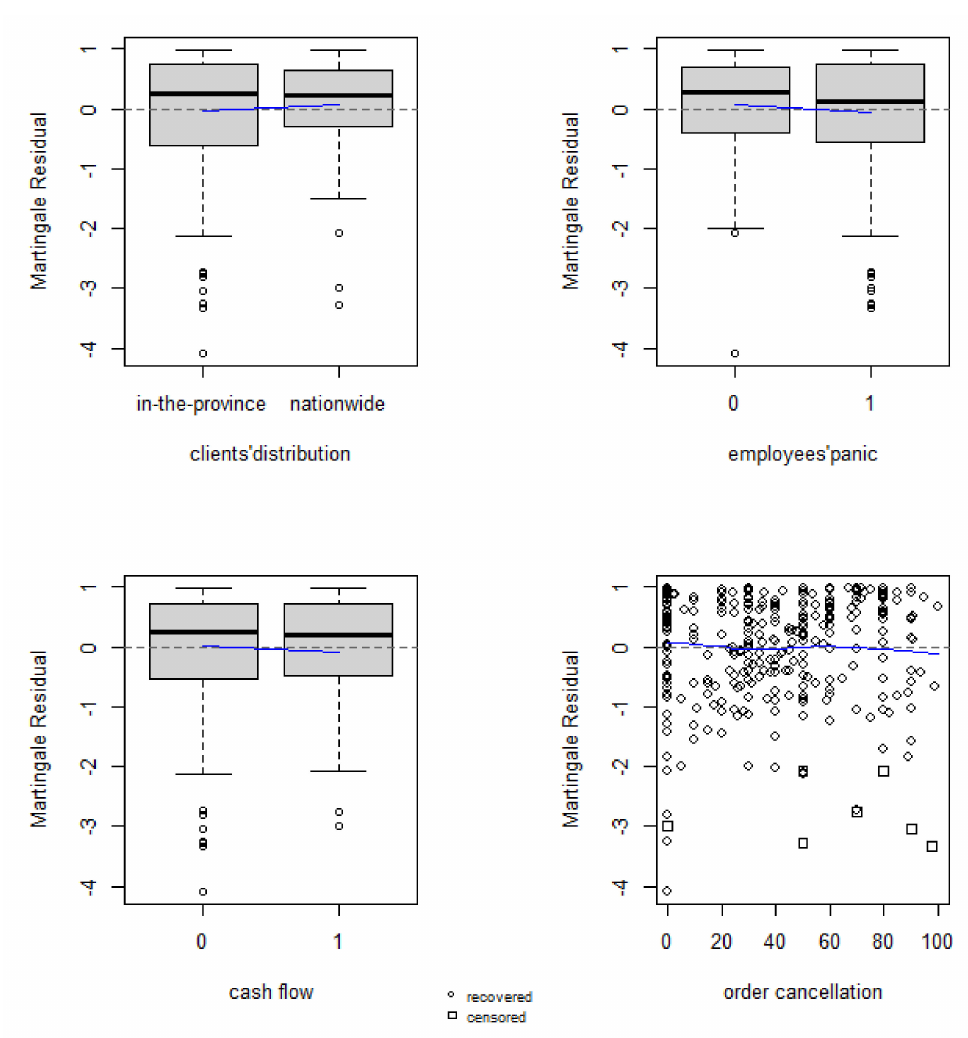
Figure 3. Plot of the Martingale residuals for